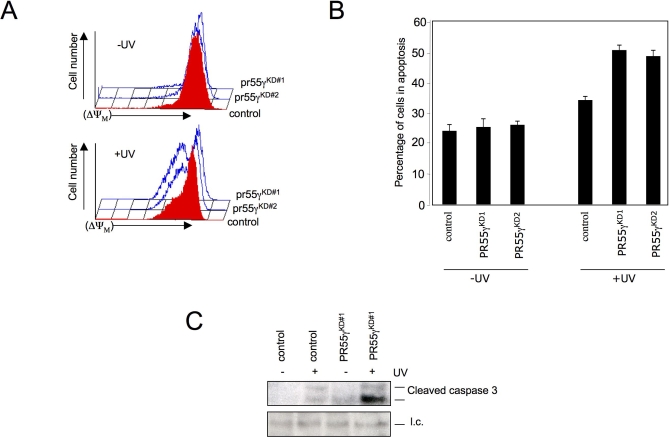
PR55γ Is a Regulator of Apoptosis following UV Irradiation(A) U2-OS cells expressing PR55γ shRNAs as indicated. Selected cells were exposed to UV irradiation (50 J/m2) and treated 18 h later with fluorescent dye measuring mitochondria membrane potential (DiOC6[3)]. FACS scan analysis of treated cells is shown. Right and left peaks reflect living and apoptotic cells, respectively. Top panel graph represents breakdown of the mitochondrial membrane potential in the absence of UV. Bottom panel graph represents breakdown of the mitochondrial membrane potential in the presence of UV.(B) Shown is the percentage of apoptotic cells treated with or without UV. Figure represents three independent experiments.(C) U2-OS cells were cotransfected with PR55γKD vector #2 or control vector. Selected cells were exposed to UV irradiation (50 J/m2) and incubated for a further 3 h. Protein samples were analyzed by immunoblotting with antibodies targeting phosphorylated cleaved caspase 3. A background band denotes loading control.doi:10.1371/journal.pgen.0030218.g003